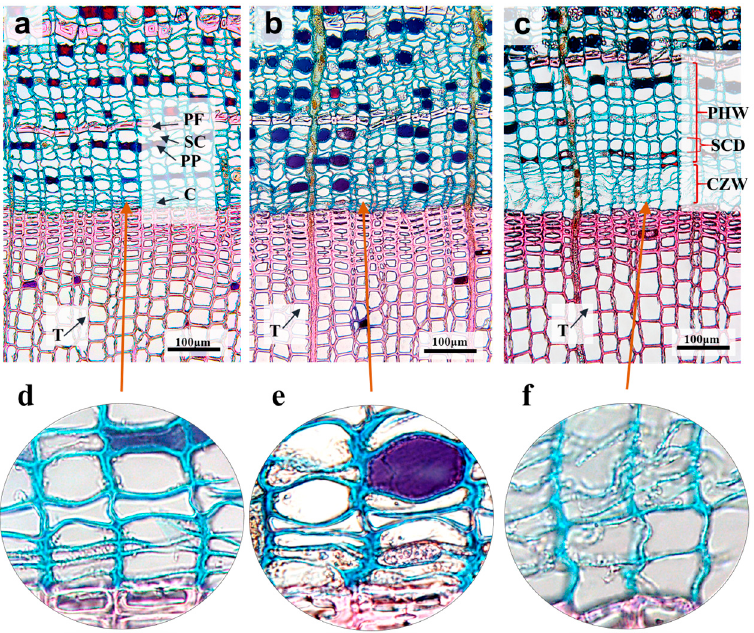
Figure 1. 2 March ( a ); 28 March ( b ); 13 April ( c ); 2 March cambium enlargement ( d ); 28 March cambium enlargement ( e ); and 13 April cambium enlargement ( f ). T: Tracheid; PF: Phloem fiber; SC: Sieve cell; PP: Phloem parenchyma; C: Cambium; PHW: Phloem width; SCD: Sieve cell inside diameter; CZW: Cambium zone width. Table 1. Statistics on the Chinese fir cambium zone data. CZW: Cambium zone width; PHW: Phloem width; SCD: Sieve cell inside